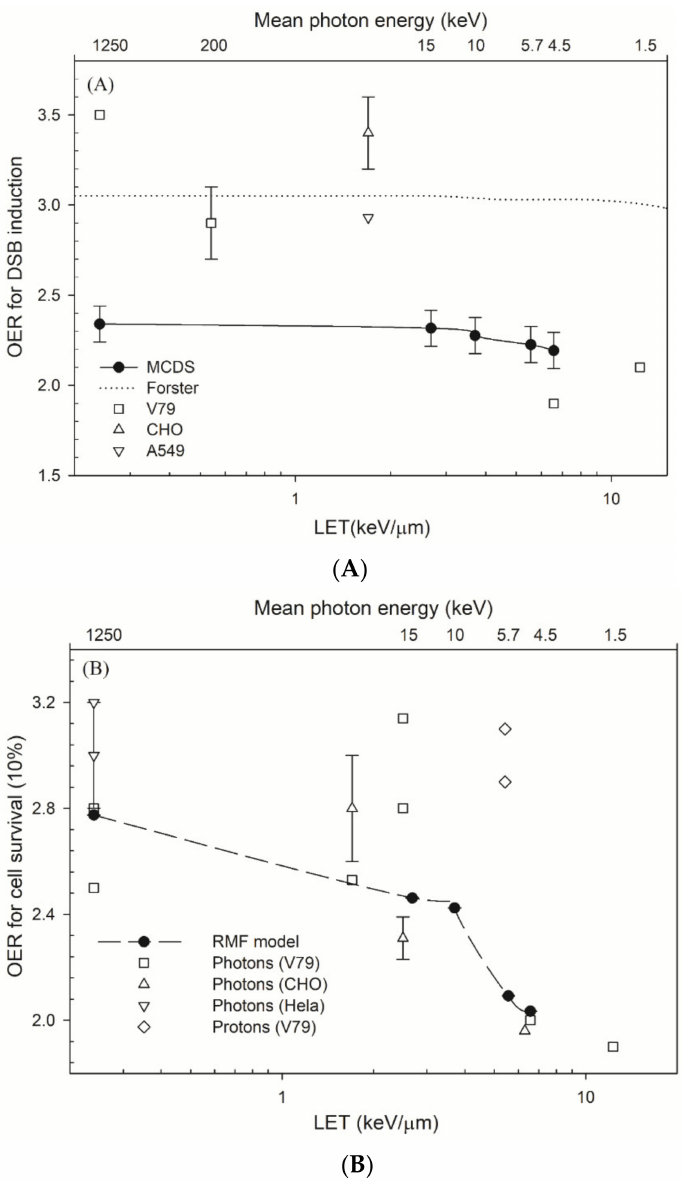
Figure 2. ( A ) Oxygen enhancement ratio (OER) for double-strand break (DSB) induction for cells irradiated by photons. The lines are the Monte Carlo damage simulation (MCDS) results and those for other Monte Carlo simulations [69]. The individual symbols represent the experimental OER values for V79 cells [17,61], Chinese hamster ovary (CHO) cells [38] and human non-small cell lung cancer A549 cells [70]. ( B ) OER for cell survival at 10% as a function of linear energy transfer ( LET ) and mean photon energy. These measured OER values are from published studies: CHO cells [38,39,71], Hela cells [72] and V79 cells irradiated with photons [17,18,40,73,74] and protons